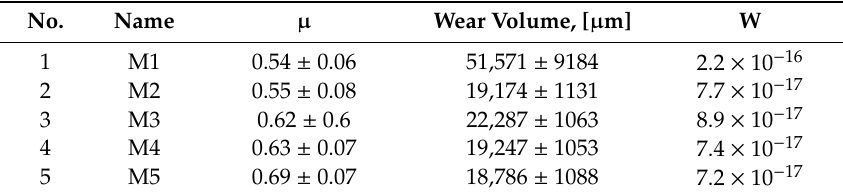
Table 10. The results of the wear test.